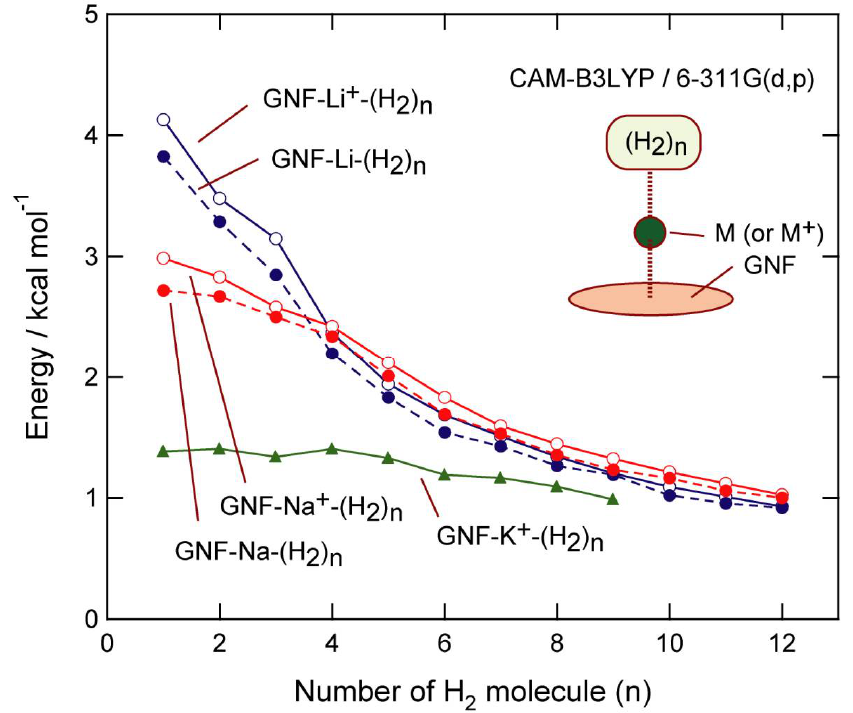
Figure 7. The binding energies of H 2 to GNF–M (per H 2 molecule) plotted as a function of n (M = Li, Li + , Na, Na + , and K + ). Calculations for M = Li, Li + , Na, Na + were carried out at the CAM-B3LYP/6-311G(d,p) level and for M = K + , it was at the CAM-B3LYP/6-31G(d) level. Reprinted with permission from [39].